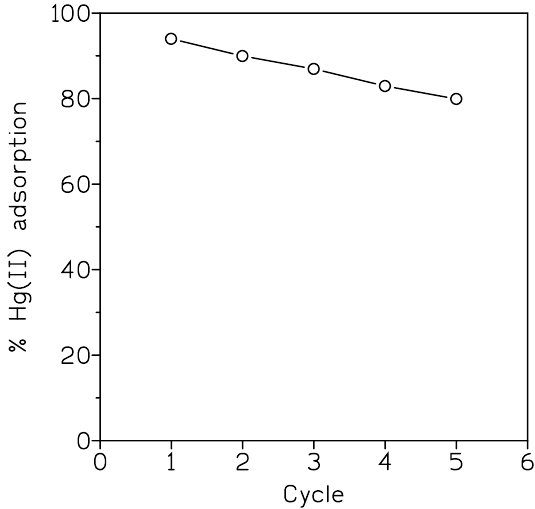
Figure 1. Lost of Hg(II) adsorption onto the adsorbent after various adsorption-desorption